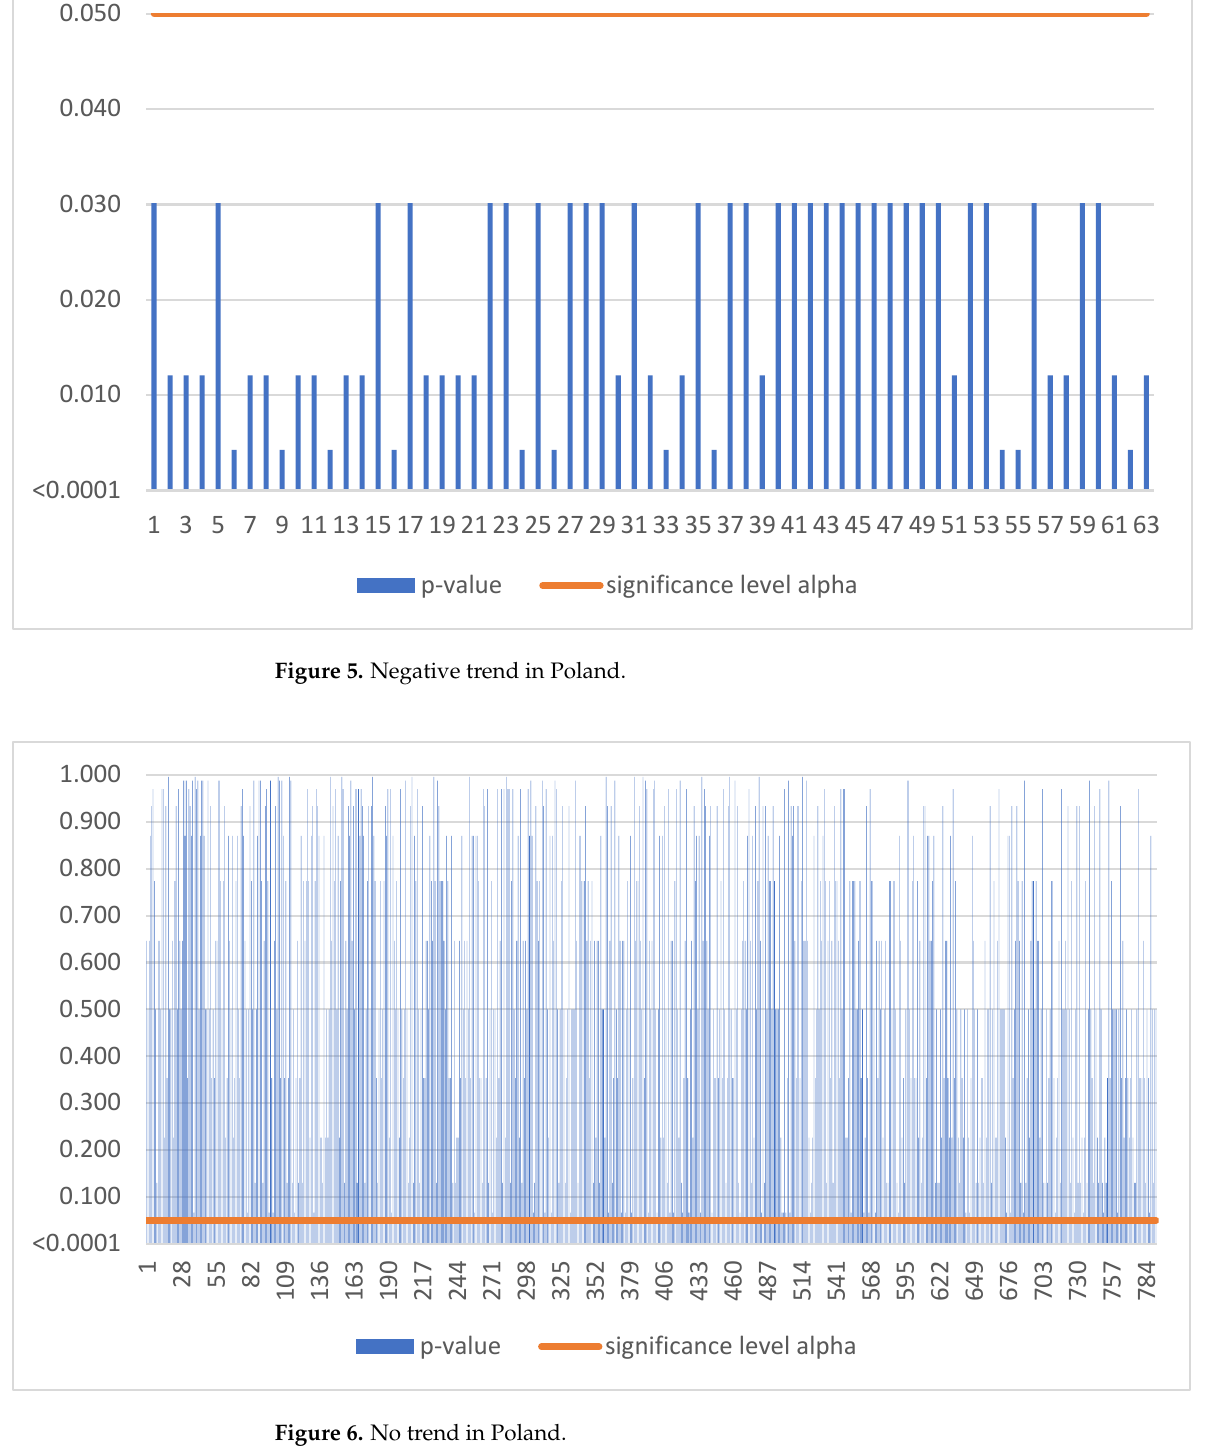
Figure 6. No trend in Poland.